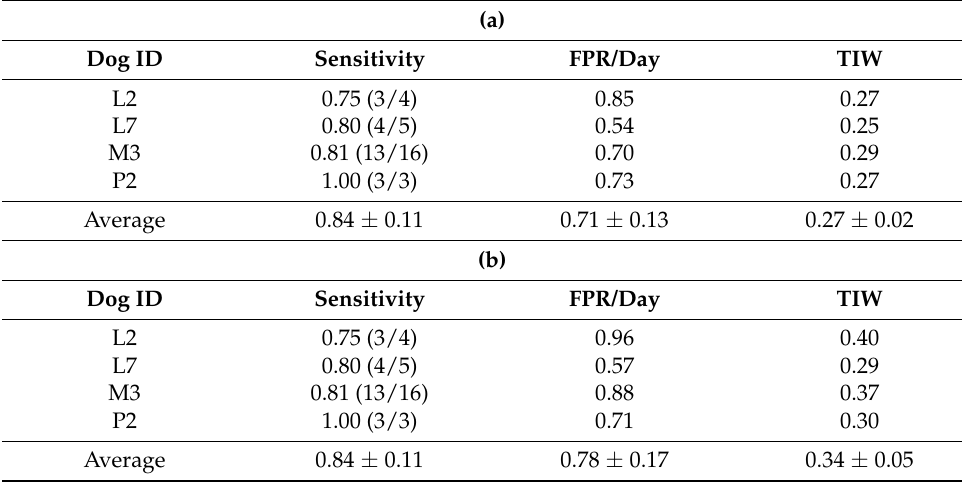
Table 3. Performance of seizure prediction system with and without window selection. ( a ) Prediction performance of online seizure prediction system with window selection. ( b ) Prediction performance of online seizure prediction system without window